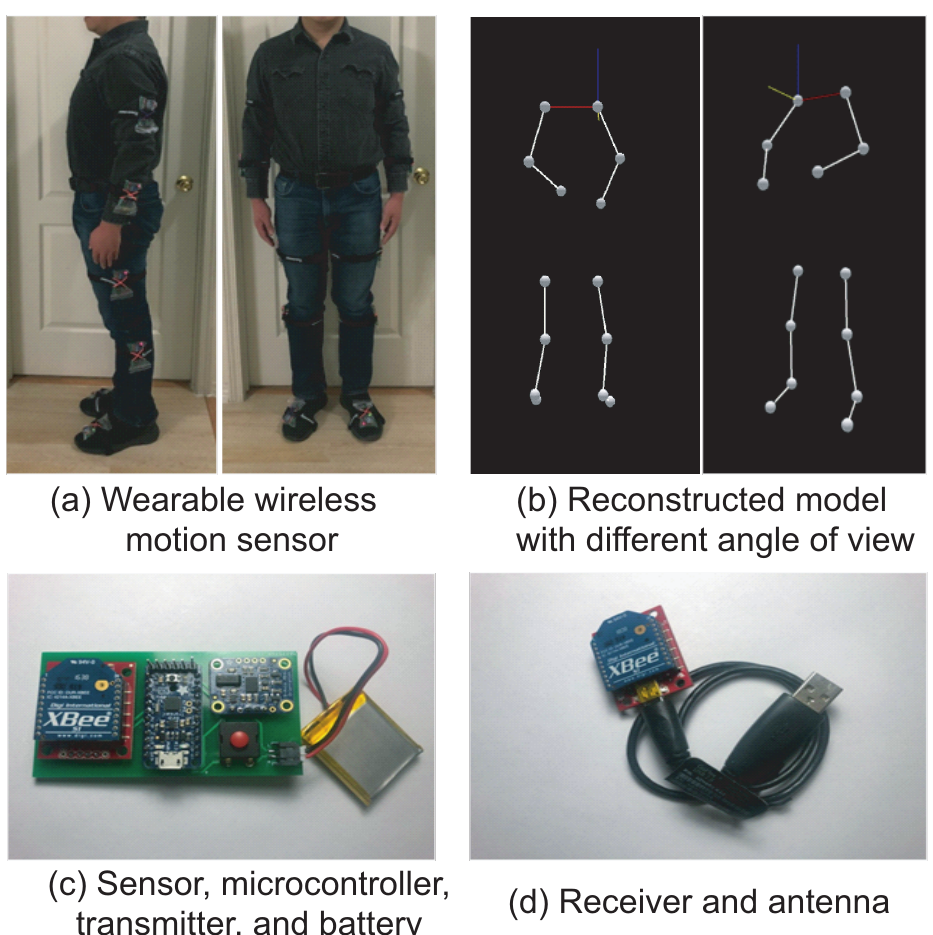
Figure 1. The proposed fully wireless wearable motion sensors and the real-time reconstructed 3D human model.